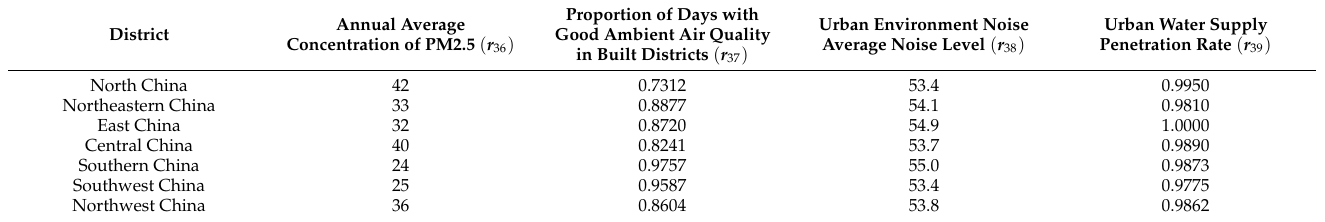
Table 6. Mean value of green infrastructure ecological function evaluation index in different regions. Proportion of Days with District Annual Average Concentration of PM2.5 ( r Good Ambient Air Quality 36 ) in Built Districts ( r 37 ) North